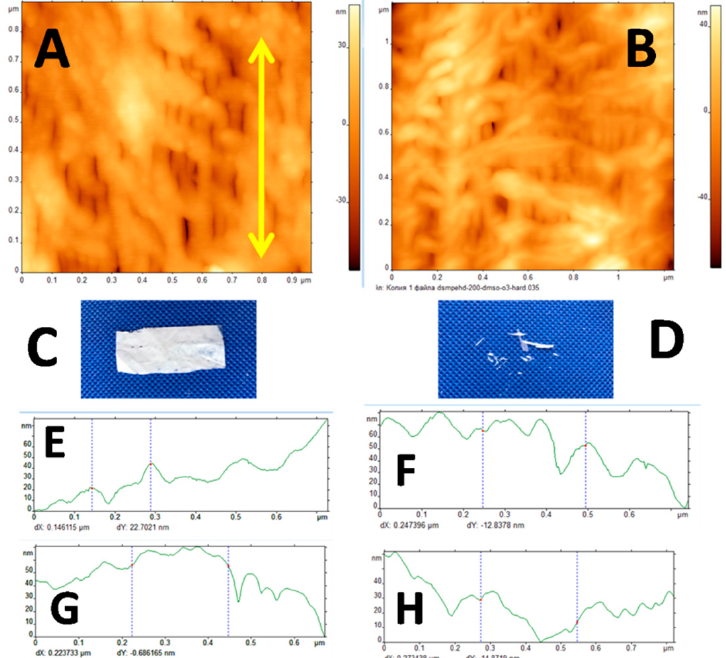
Figure 7. ( A , B ) AFM micrographs, ( C , D ) snapshots, and ( E – H ) profilogramsof the HDPE membranes after ( A , C , E , G ) “mild” (600 s) and ( B , D , F , H ) “severe” ozonation (25,200 s); profilograms ( E , F ) along the direction of tensile drawing and ( G , H ) in the transverse direction (direction of tensile drawing is shown by the arrow).